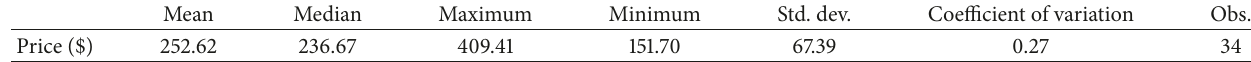
Table 1: Summary of data statistics: annual wheat price in USD/MT, deflated to 2013 dollars.